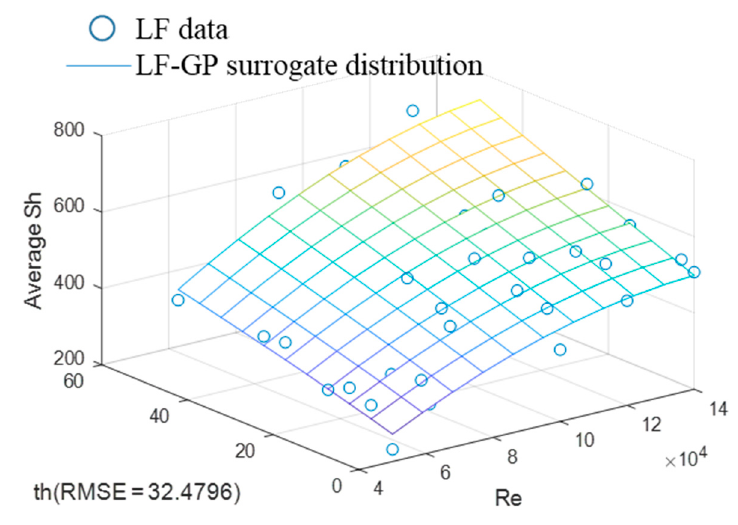
Figure 4. Distribution of averaged heat transfer coefficient (HTC) by LF-Gaussian process (GP) surrogate using LF data.